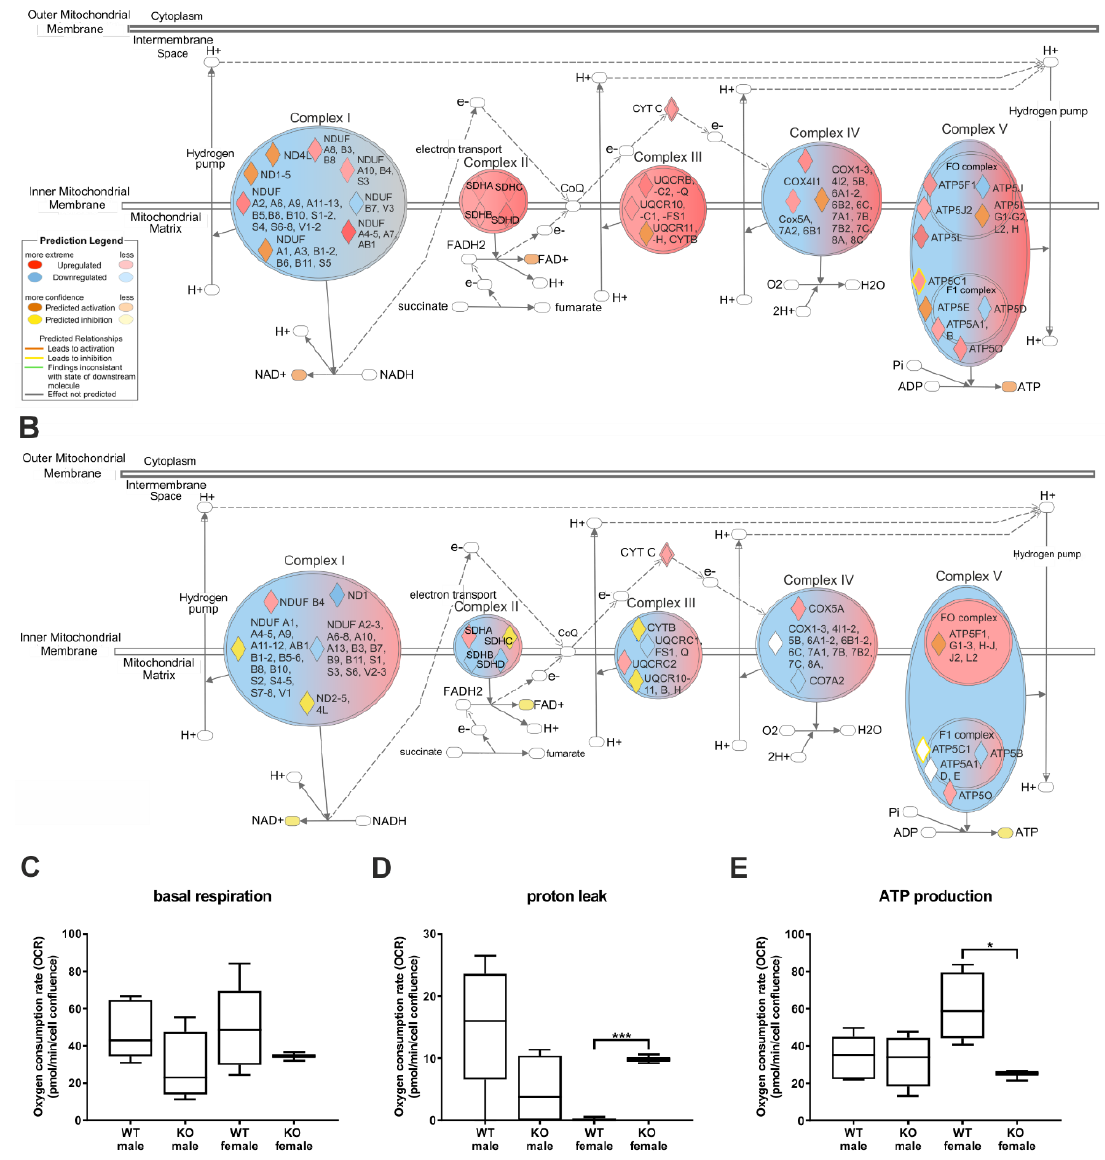
Figure 1. The impact of the hepatocyte-specific knockout of Hedgehog signalling on mitochondrial respiration. ( A , B ): Ingenuity Pathway analysis (IPA) of the electron transport chain based on proteome data of male ( A ) and female ( B ) SAC mice. ( C – E ): Seahorse analysis Mito Stress Test of SAC mice. Data are normalized to the respective wildtype (WT). Significance was calculated with unpaired t-test. Stars show the significance to WT animals. * p ≤ 0.05, *** p ≤ 0.001; n = 3−8.